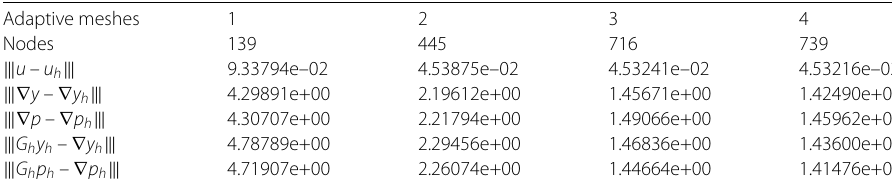
Table 3 Numerical results on adaptive meshes, Example